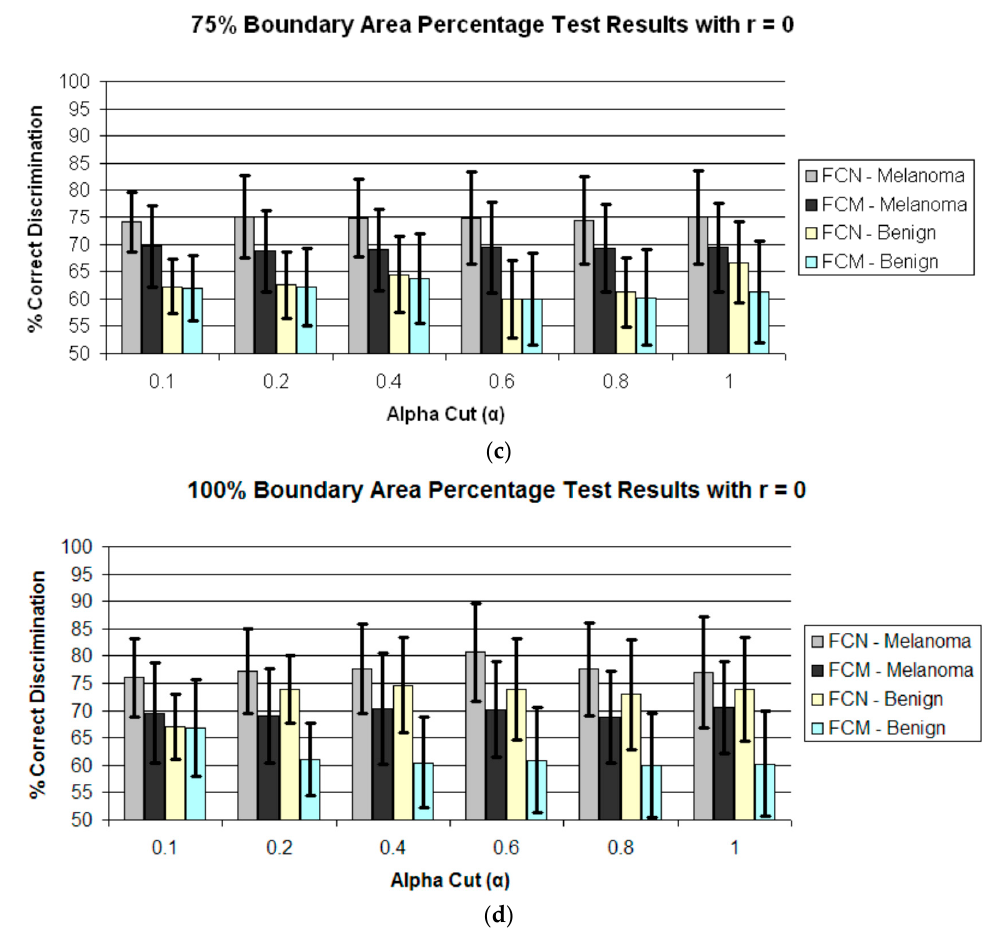
Figure 4. Average and standard deviation test results over 25 randomly generated training/test sets for different boundary area percentages for r = 0. FCN and FCM denote the fuzzy ratio features computed using the benign and melanoma training images to determine discrimination accuracy. ( a ) Boundary area percentage = 10%; ( b ) Boundary area percentage = 25%; ( c ) Boundary area percentage = 75%; ( d ) Boundary area percentage = 100%.